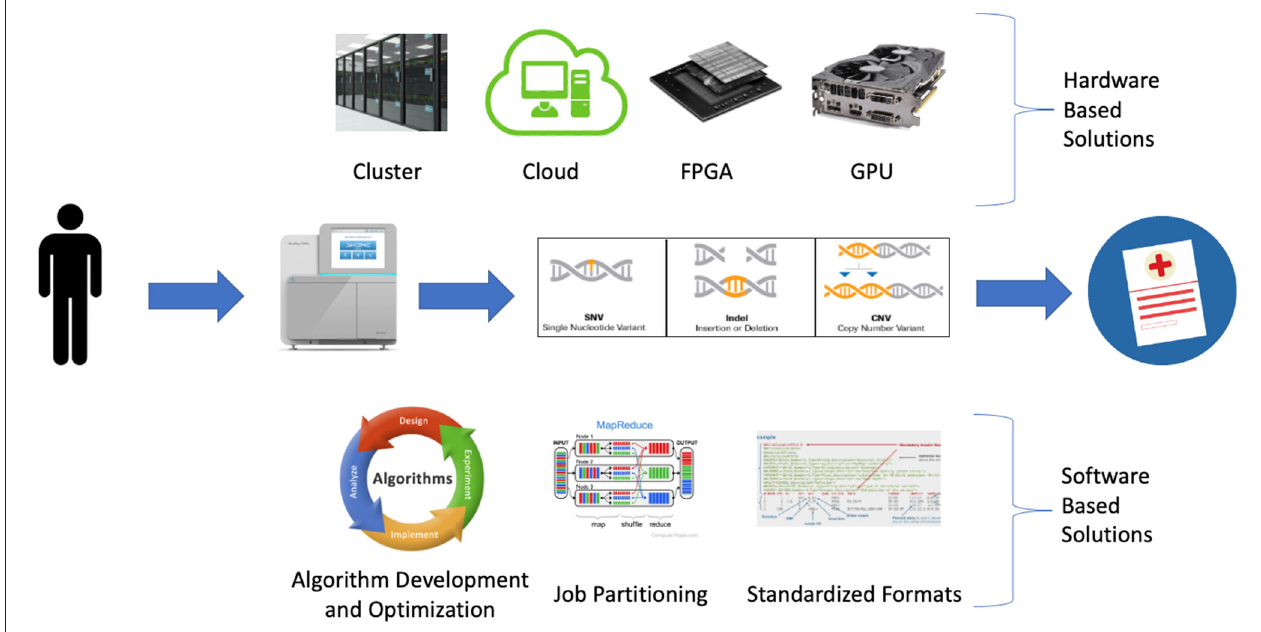
TABLE 2 | Software based solutions. Strategy Advantages Disadvantages Algorithm development Algorithm